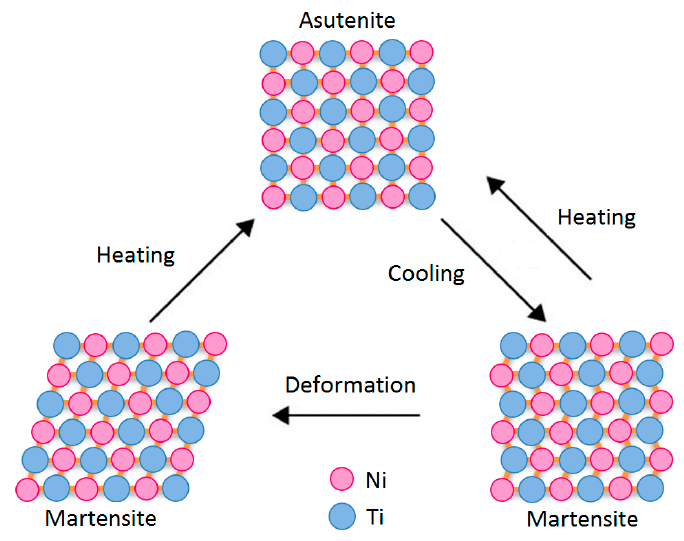
Figure 3. Transformation between the martensite and the austenite phases.